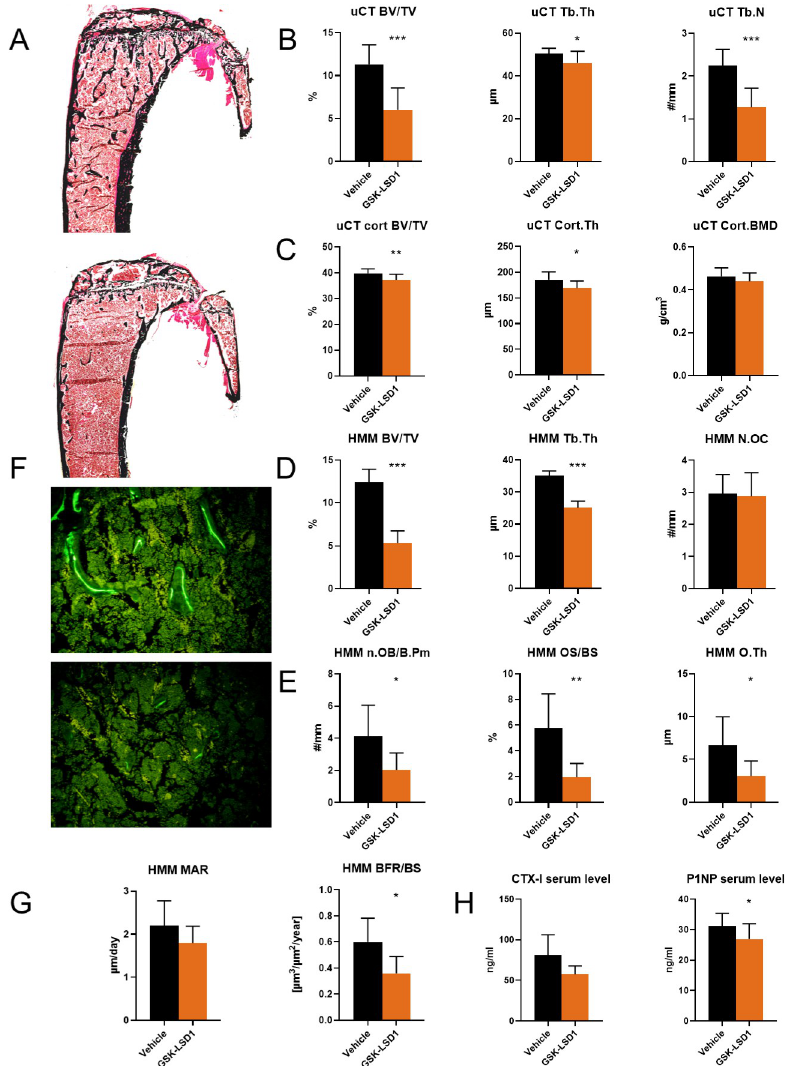
Fig 3. Lsd1 inhibitor treatment in vivo. (A) Representative images of Von Kossa stained control (top) and GSK-LSD1 treated (bottom) MMA embedded sections. (B) μ CT analysis of trabecular bone. (C) μ CT analysis of cortical bone. (D) Histomorphometric analysis of trabecular bone structural parameters. (E) Histomorphometric analysis of osteoblast parameters. (F) Representative images of fluorescent labels in control (top) and GSK-LSD1 treated (bottom) samples. (G) Histomorphometric analysis of dynamic parameters, (H) Bone resorption marker CTX-I and bone formation marker P1NP serum levels. Mice were treated with either 1,5mg/kg GSK-LSD1 or saline on a 4-on-3-off schedule for 4 weeks, n = 10/group). P-values for statistically significant differences are marked � P < 0.05, �� P < 0.01, ��� P < 0.001.